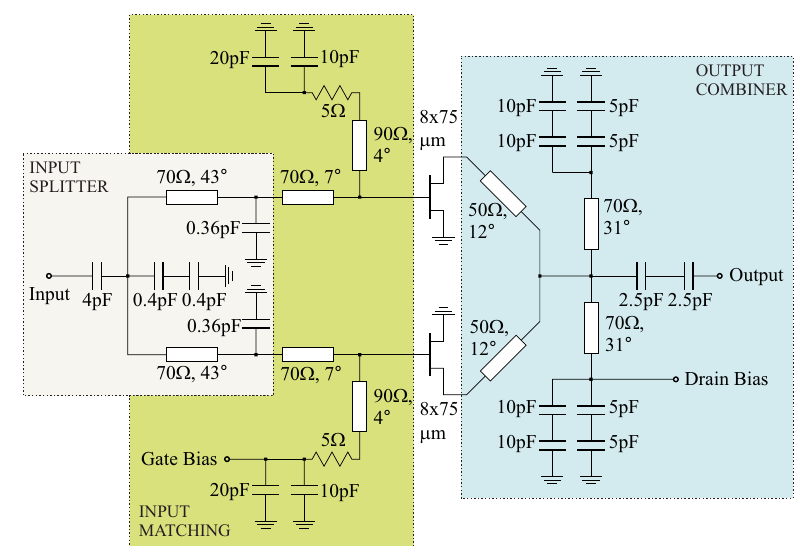
Figure 9. Complete scheme of the 15 GHz combined Amplifier. Equivalent ideal lines are represented: electrical length refers to 15 GHz.